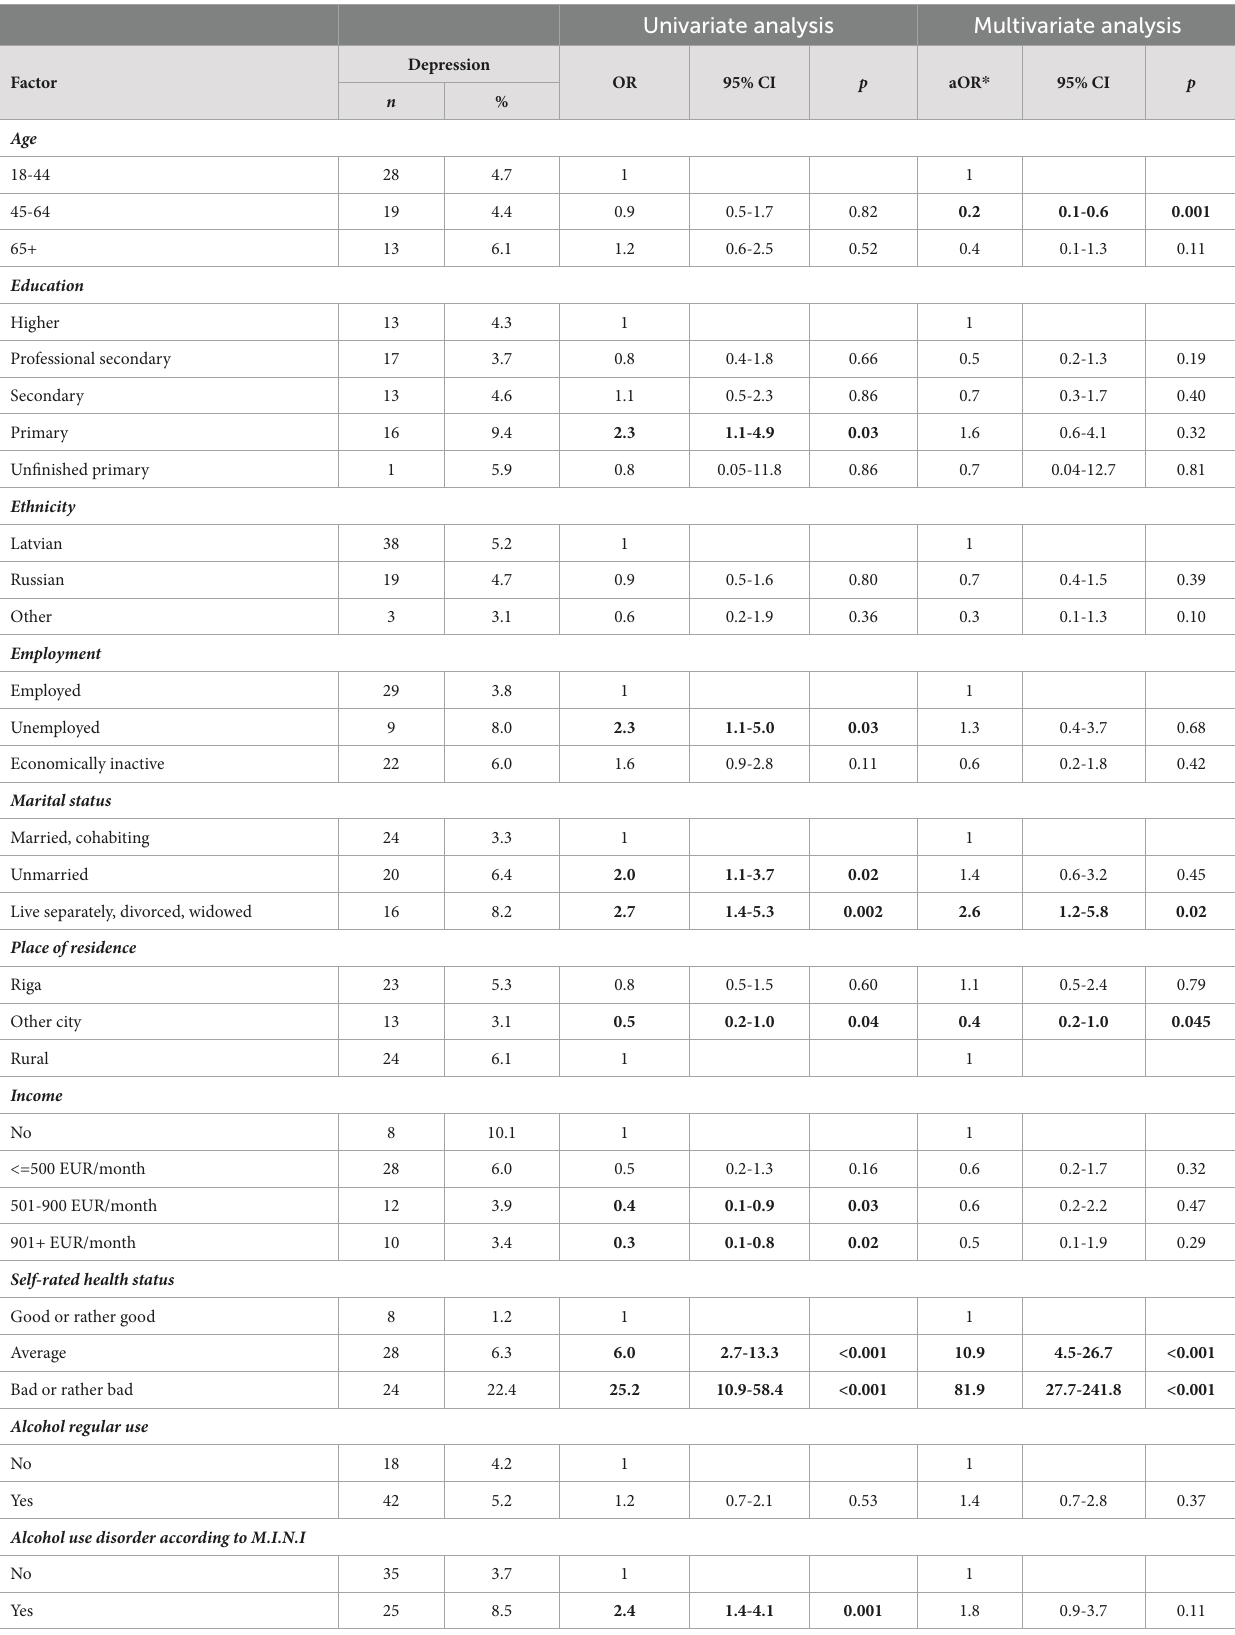
TABLE 2 Prevalence of depression in males, results of univariate and multivariate logistic regression analysis Univariate analysis Multivariate